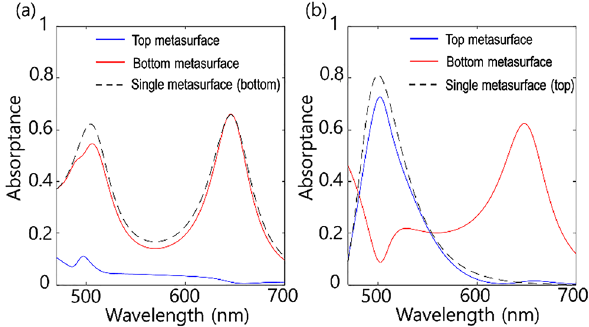
Figure 2: Simulated absorption spectrums illustrating switched couplingoflightwiththetopmetasurfacepositionedattheheightof h 1 (145 nm) and h 2 (225 nm) respectively. (a) Absorptions with the top metasurface at the height of h 1. The bottom metasurface (red line) excites resonances at both wavelengthsof500and645nm,whichleadstotheabsorptionoftop metasurface (blue line) being broadly suppressed. Black dashed line indicates the absorption of bottom metasurface without the vertical integration which closely resemblesthe spectrumof bottom metasurface with vertical integration. (b) Absorptions with the top metasurface at the height of h 2. The absorption of bottom metasurface (redline) is effectivelysuppressedat thewavelengthof 500 nm at which the top metasurface (blue line) excites the resonance. Black dashed line indicates the absorption of top metasurface with bare silver re fl ector, which closely resembles the absorption of integrated